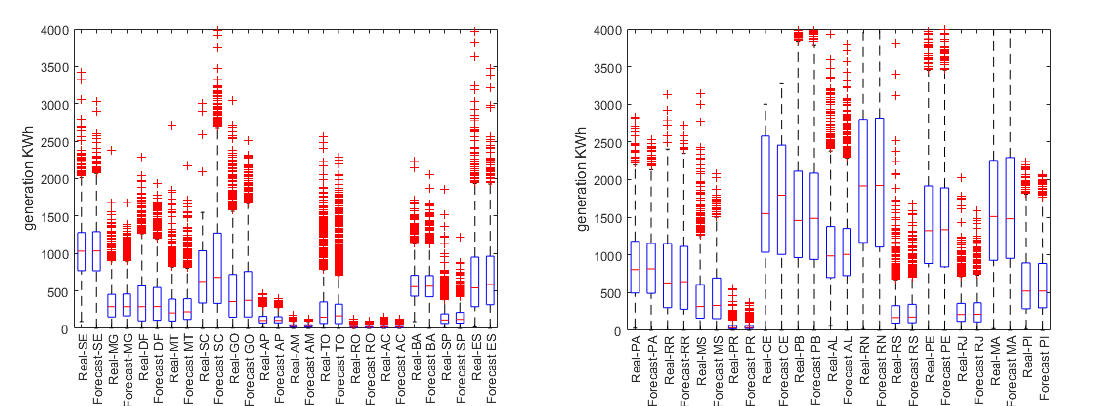
Figure 2. Boxplot for Brazilian states on 10 years sample (1–10)—comparing real generations, and the forecasting